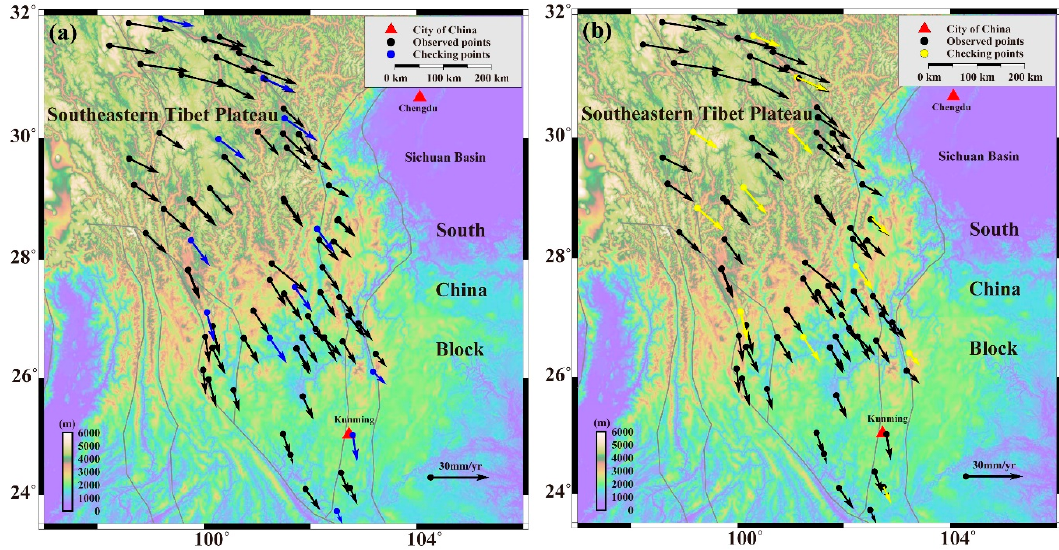
Table 4. RMS of the fitting points and checking points using four algorithms (Experiment 3).